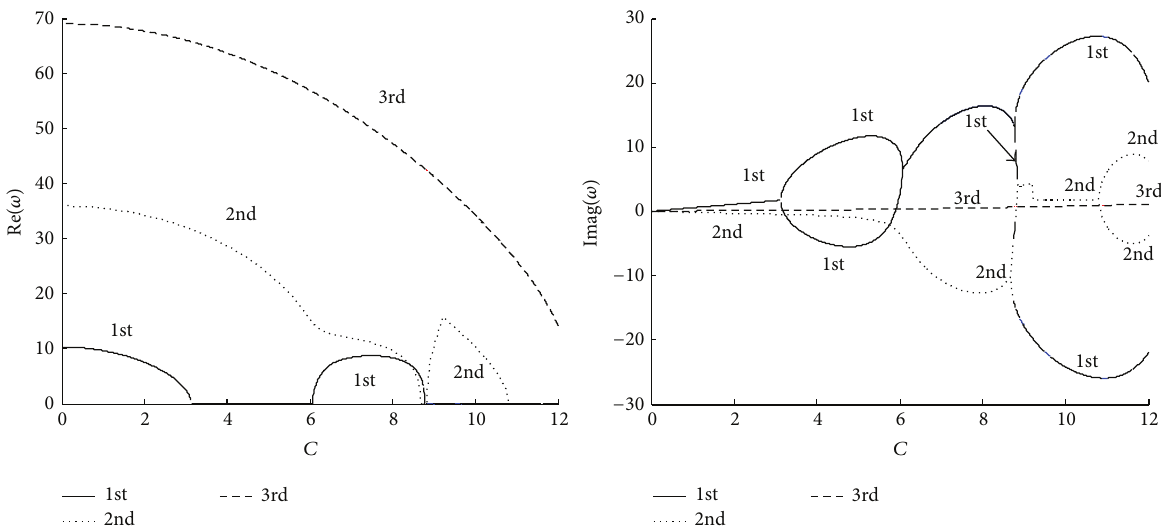
Figure 2: Dimensionless complex frequencies versus dimensionless axially moving speed 𝐶 ( 𝐻 = 10 −5 , 𝑞 = 50 , 𝑟 = 1 , 𝑈 = 0 , and 𝜆 = 0.05 ).